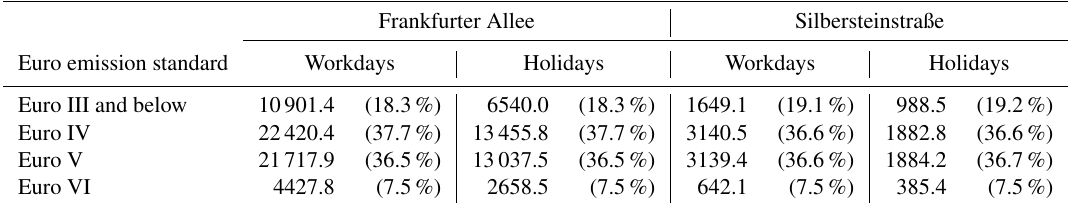
Table A2. Mean daily traffic count for typical workdays and holidays on Frankfurter Allee and Silbersteinstraße in Berlin, classified by Euro emission standards.